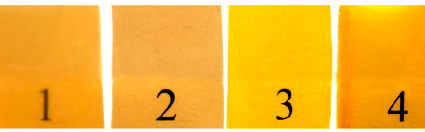
Figure 1. Optical images of membranes: ( 1 ) TPEQ-ODPA (polyimide based on 1,4-bis(4-aminophenoxy) benzene with 4,4’-oxydiphthalic anhydride); ( 2 ) Prepared mixed-matrix membrane (MMM) with